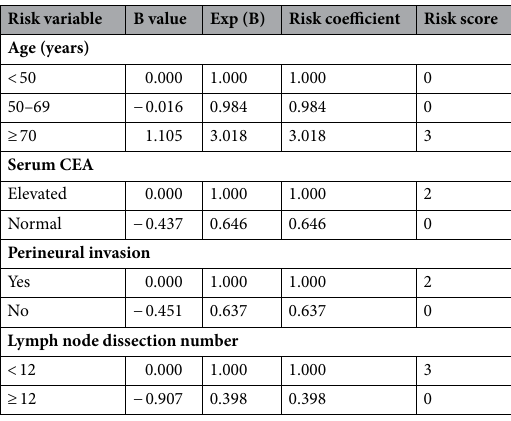
Table 3. Risk scoring system. CEA carcinoembryonic antigen.